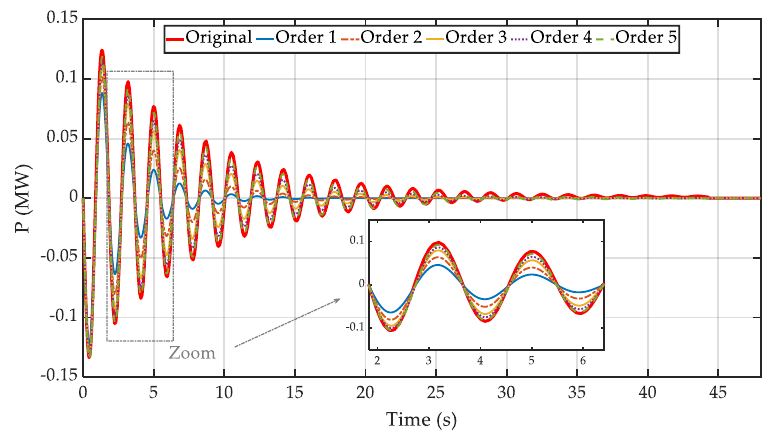
Figure 11. Impact of model order. Prony method.